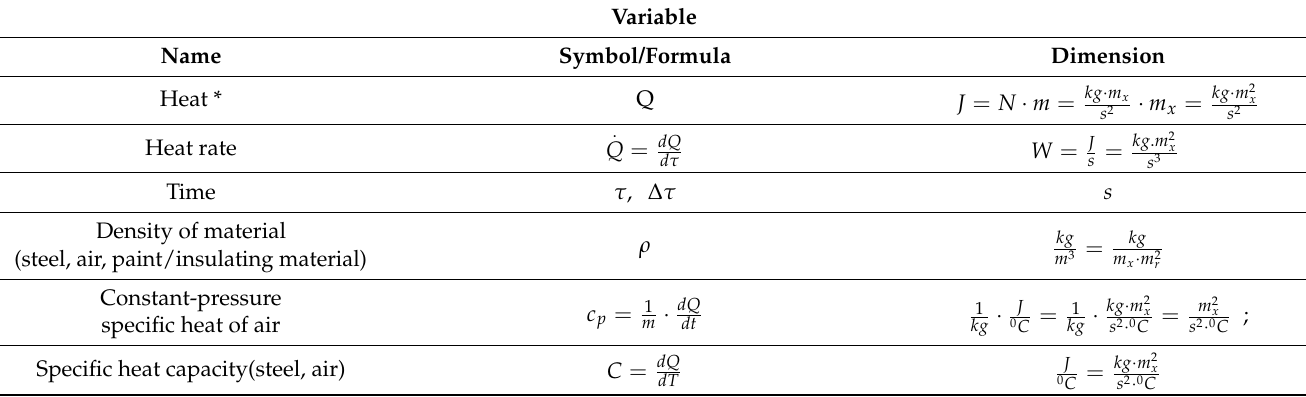
Table 1. The set of variables that govern the heat transient transfer in a beam with circular